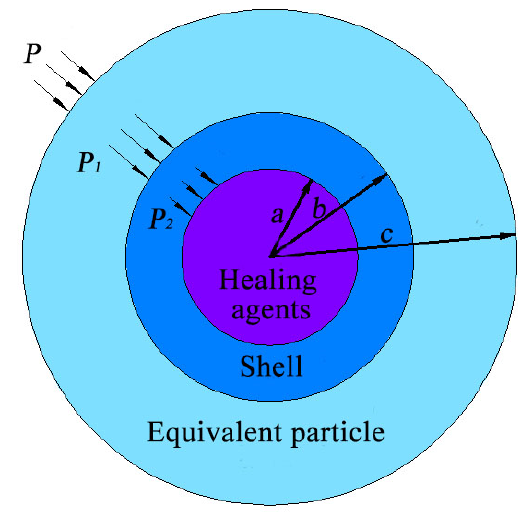
Figure 3. A multilayer-coated model for self-healing microcapsules.